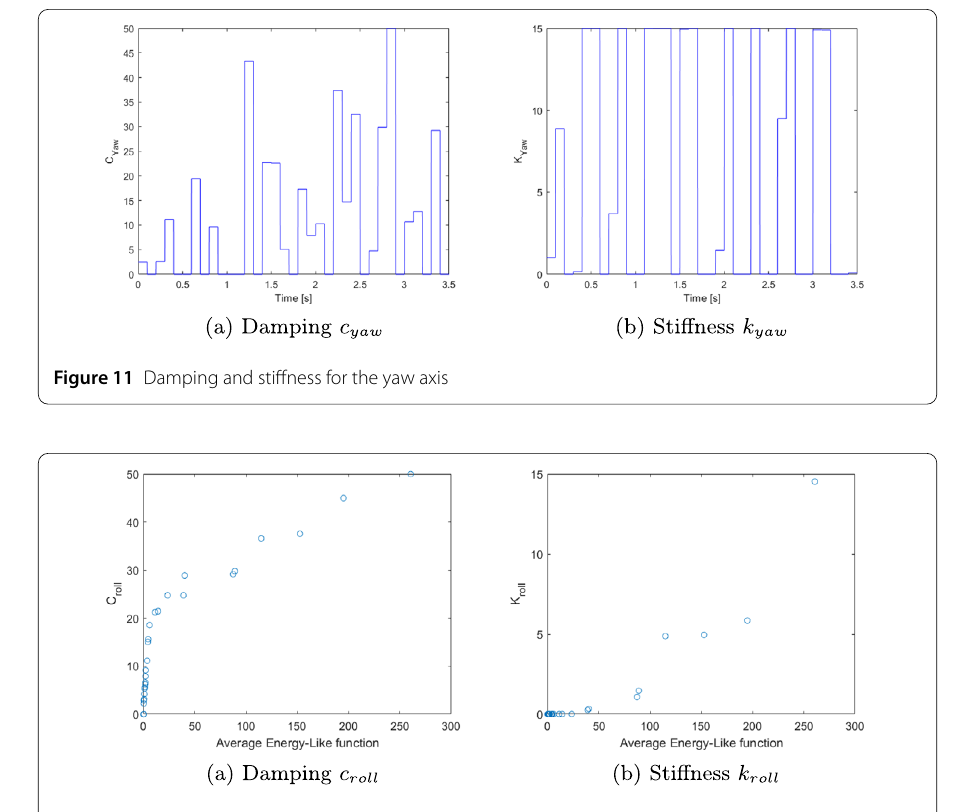
Figure 12 Damping and stiffness for the roll axis against the average kinetic energy-like function